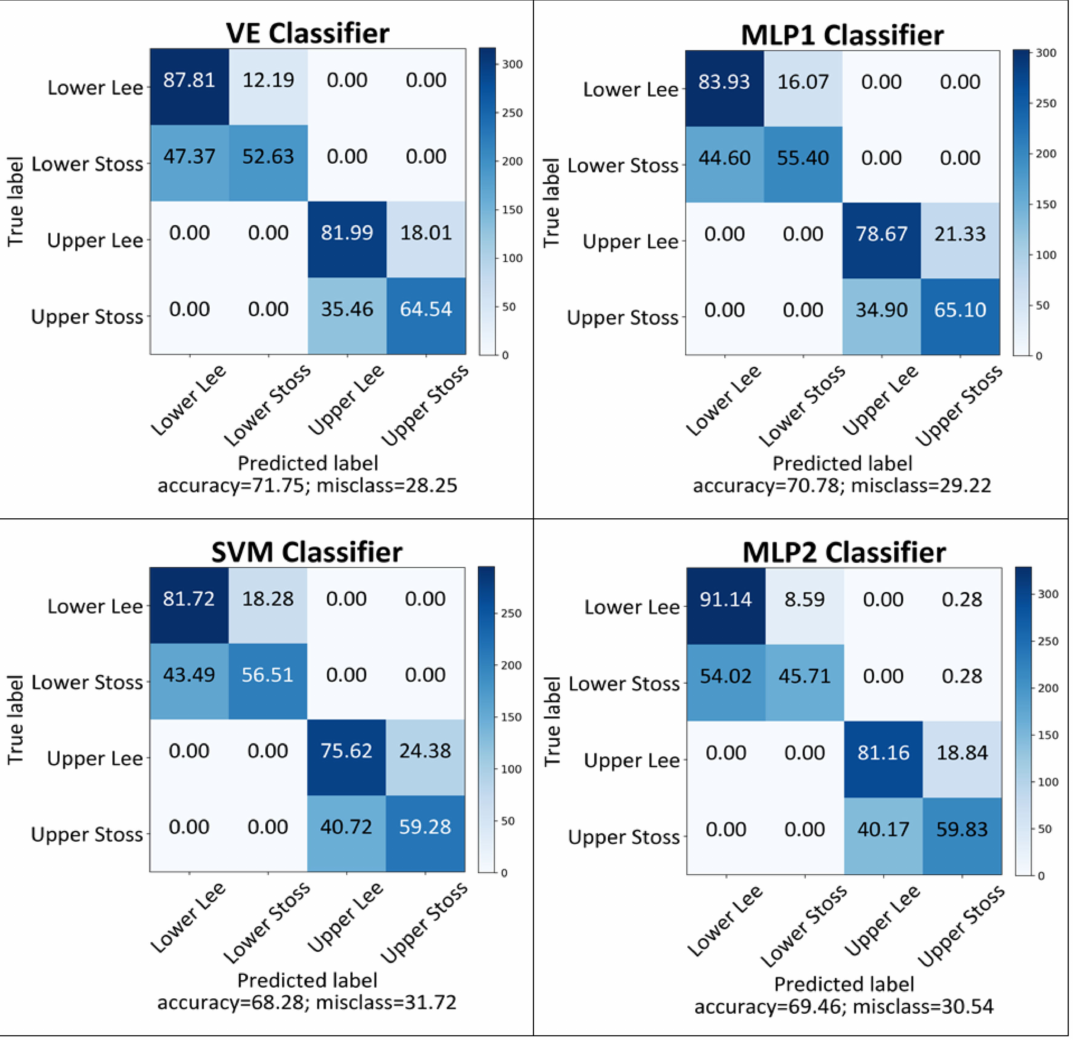
Figure 6. Confusion matrices for the VE, MLP1, SVM, and MLP2 classifiers derived from the overall OSW